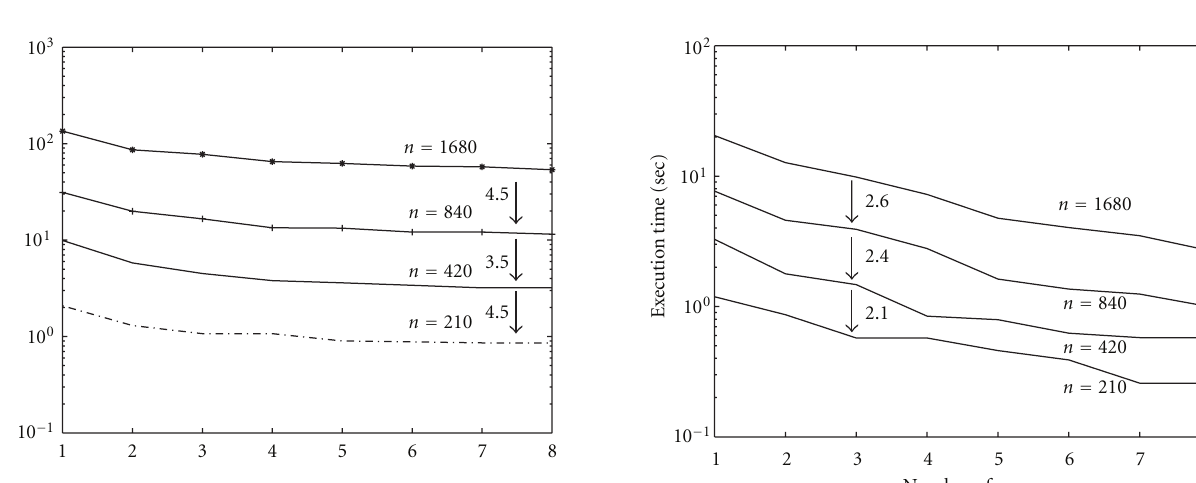
Figure 27: Scalability of parallel Algorithm SI, as N is fixed and p varies, and N = 210,420,840,1680. Each line refers to the execution time of the algorithm at a fixed value of N .